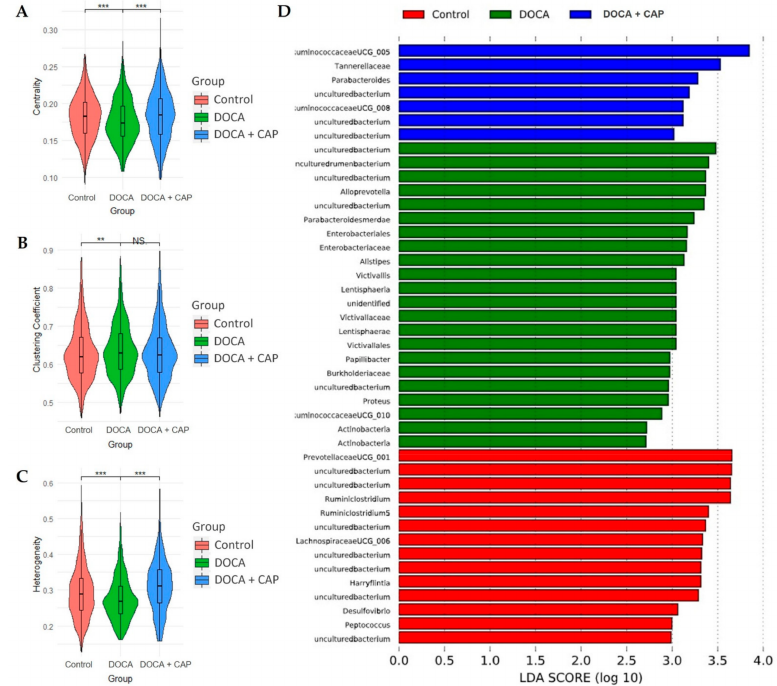
Figure A4. The centrality ( A ), clustering coefficient ( B ), and heterogeneity ( C ) of the correlation network between the abundance of genus level in the Control, DOCA, and DOCA + Captopril groups. Inter-group comparisons were conducted using one-way ANOVA followed by the Tukey HSD post hoc test. ( D ) The log-LDA score of the gut genera, all genera shown in the plot have significant LDA-based effect size ( p < 0.05). (*** p < 0.001, ** p <